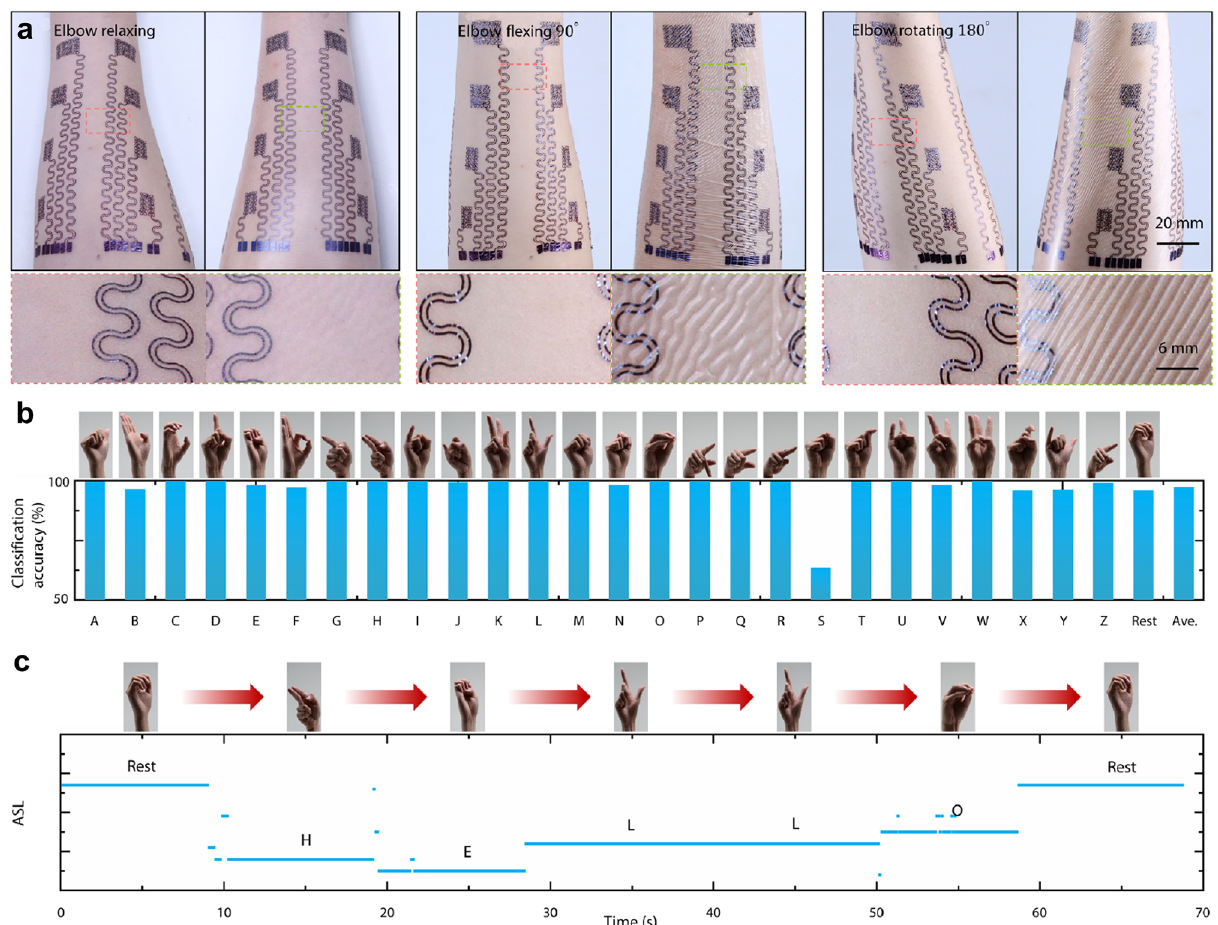
Fig. 25 FNN for recognizing ASL. a Photographs and corresponding optical micrographs of large-area epidermal electrodes with and without substrate attached on forearm. b Classification accuracy of 26 ASL alphabets and a rest gesture, respectively. c One trial of the continuous recog- nition of the sign language saying “HELLO” consists of single letter. Reproduced with permission [338]. Copyright (2020), American Associa- tion for the Advancement of